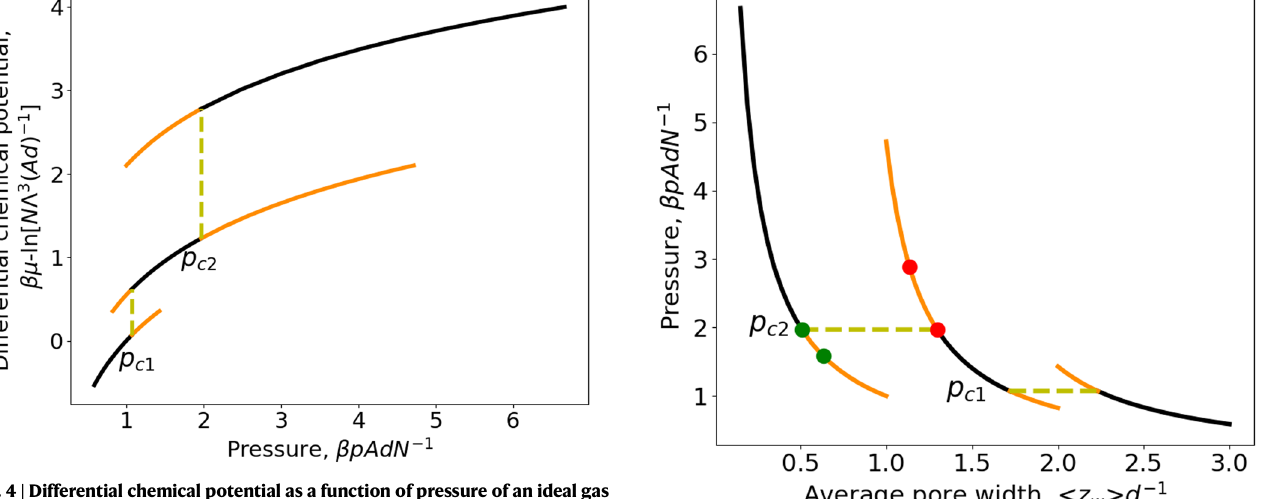
Fig. 4 | Differential chemical potential as a function ofpressure ofan ideal gas con fi nedin a slit pore. Repulsive square-wellgas-wallpotential ð ε <0 Þ at areduced temperature, T =0 : 9525 ∣ ε ∣ k B (cid:1) 1 ð e βε =0 : 35 Þ . The large-pore branch is the lowest one giving thermodynamically stable states on the black part and metastable states on the orange part (above p c 1 ). The intermediate-pore branch is the middle one giving thermodynamically stable states on the black part and metastable states on the two orangeparts(below p c 1 orabove p c 2 ).Thesmall-porebranchisthehighestonegiving stable states on the black part and metastable states on the orange part (below p c 2